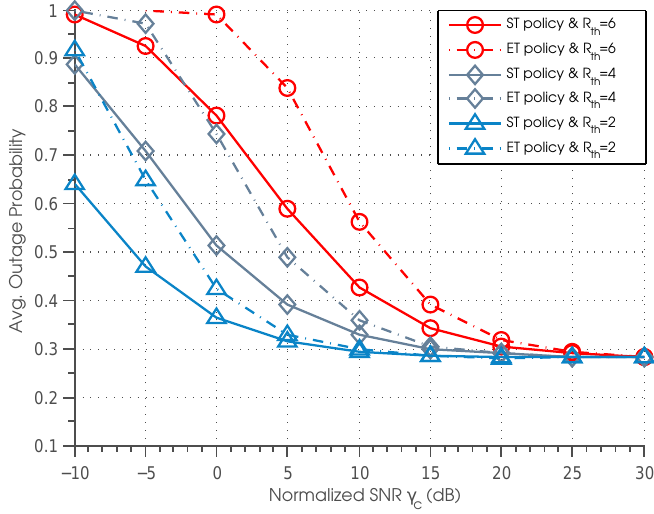
Figure 7. Average outage probability vs. normalized